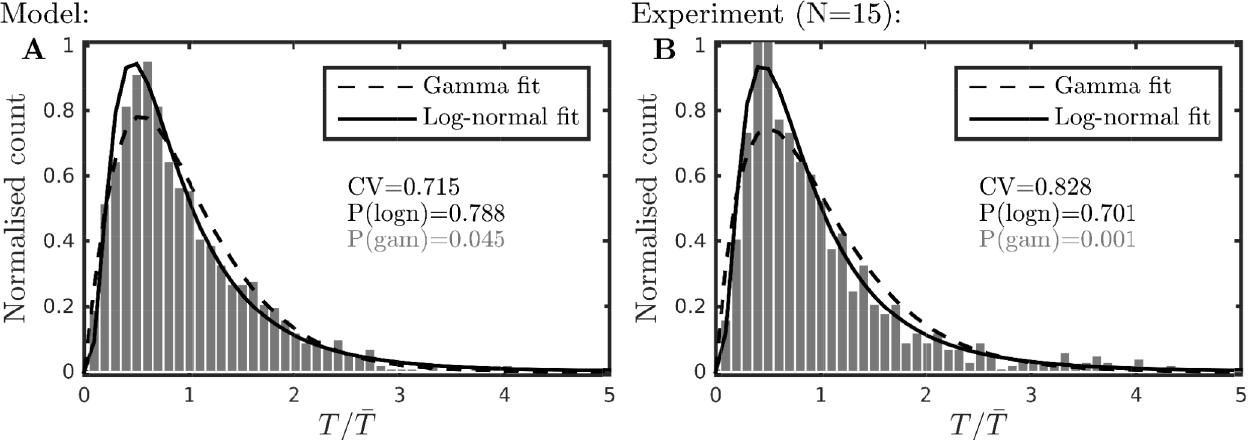
Fig 5. Statistics of dominance durations. A : Histogram of 1000 durations from model simulations at Δ f = 5 combined across perceptual type after normalising by the mean, see text. Curves show best-fit by gamma and log-normal distributions, P-values from one-way KS test are shown (in gray if the distribution can be rejected at the 0.05 significant level). B : As in A, here for the experimental condition Δ f = 5; normalized data combined across